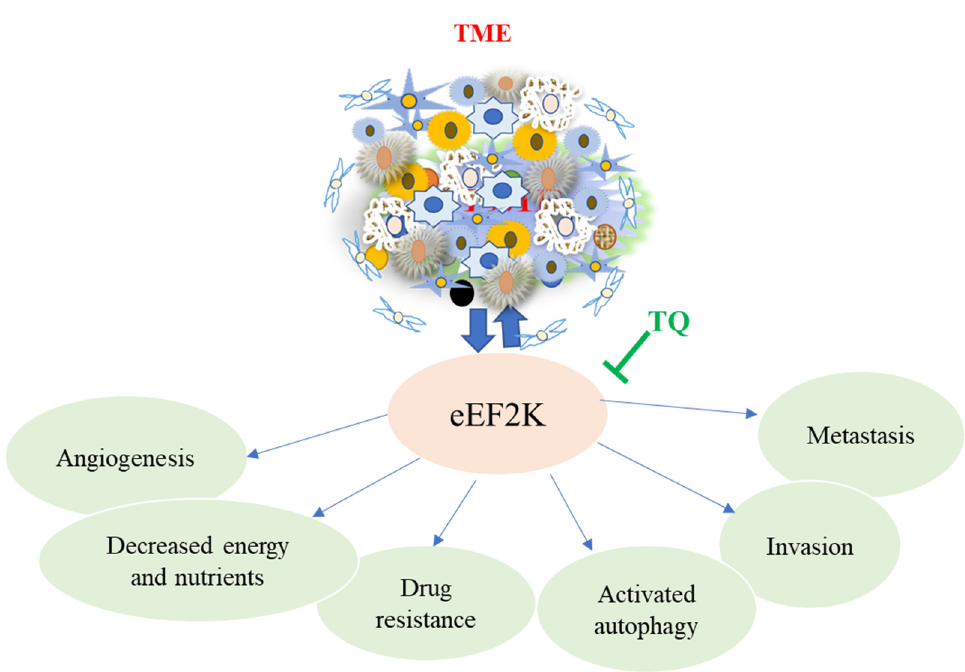
Figure 4. The major role of eEF2K in promoting angiogenesis, metastasis, invasion, and drug resistance in cancer cells, including TNBC. These effects promote cancer progression, resulting in tumor growth, poor prognosis, and short survival in TNBC patients. TQ reverses this action by regulating and inhibiting the upregulation of eEF2K in the